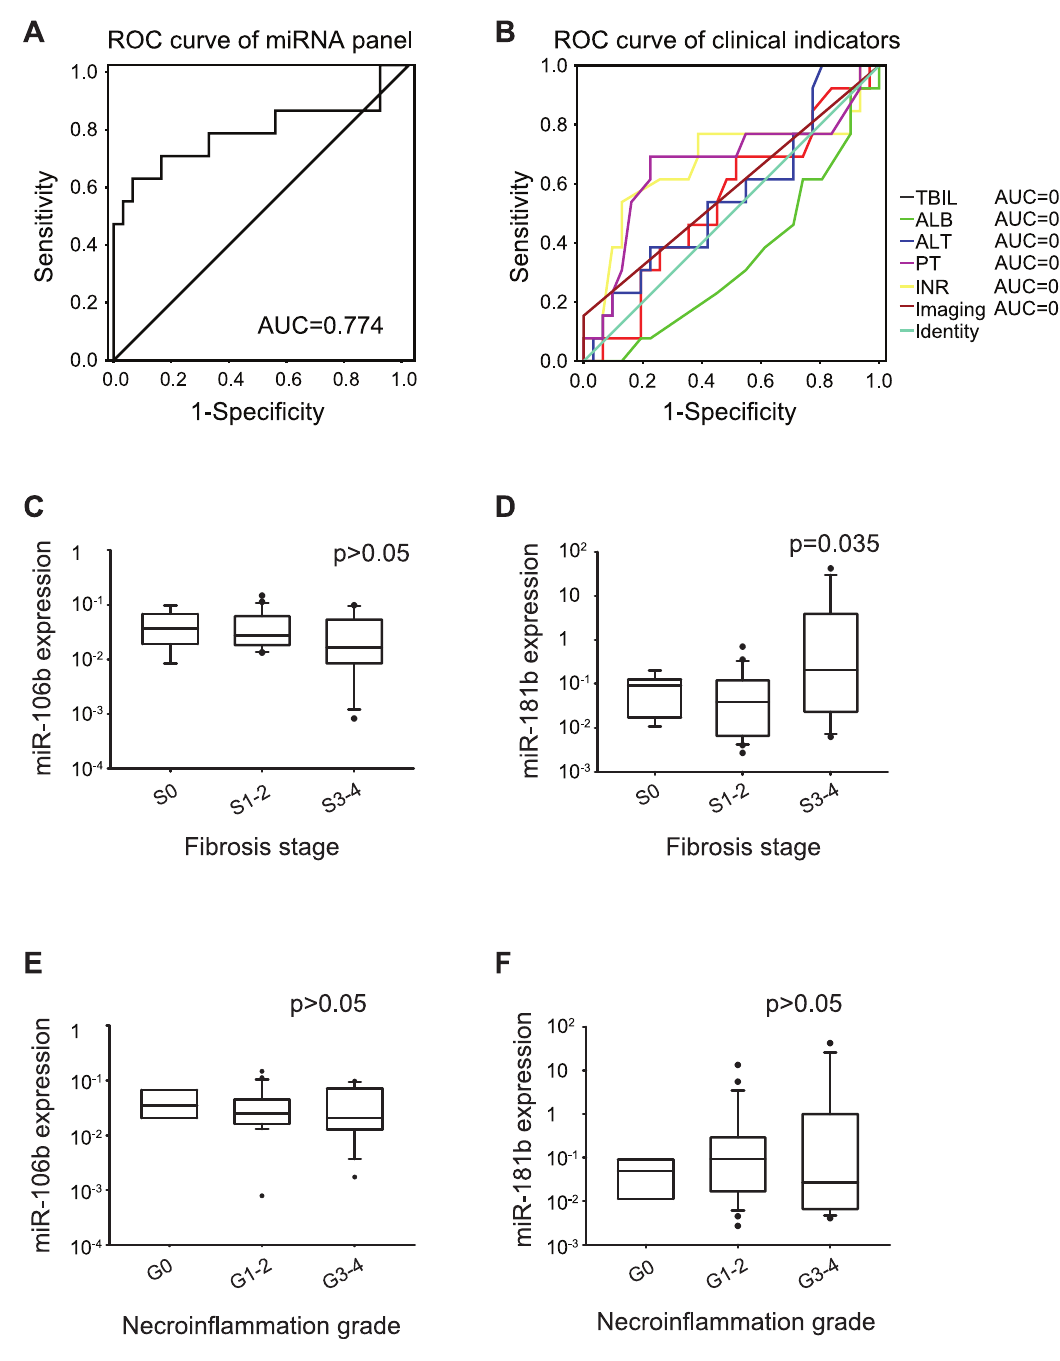
Figure 4 . Plasma miR-106b and miR-181b levels in CHB-related silent cirrhosis cohort. ROC curve analysis showed that the diagnostic power of miRNA classifier (A) was higher than the diagnostic powers of single clinical indicators (B). Kruskal-Wallis test was used to determine the statistical significance of miR-106b (D and E) and miR-181b (C and F) in different fibrosis and necroinflammation grades. TBIL, total bilirubin; ALB, albumin; ALT, alanine aminotransferase; PT, prothrombin time; INR, international normalized